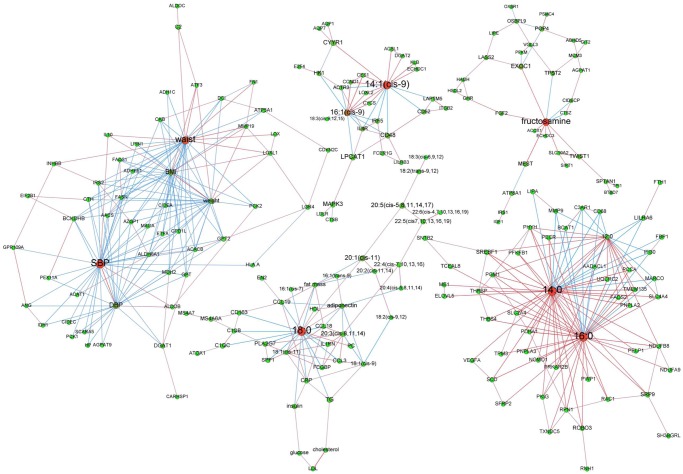
Adipose tissue networks during maintenance phase in women regaining weight.A sparse Graphical Gaussian Model (GGM) was used to estimate partial correlations in each set of variables and regularized canonical correlation analysis (CCA) was used to assess links between paired sets of variable. Clustering was performed using a spin glass model and simulated annealing. This analysis displays the variables that are connected independently from other variables. Graphs were laid out using force-based algorithms in Gephi 0.8.2 software. Nodes’ colors and font size indicate betweenness centrality. The red nodes have the highest betweenness and the green nodes the lowest one. Edge thickness is proportional to the strength of the correlation (CCA) or of the partial correlation (GGM). Edge color indicates the correlation sign: red for positive correlations and blue for negative ones. BMI, body mass index; CRP, C reactive protein; DBP, diastolic blood pressure; HDL, high density lipoprotein; LDL, low density lipoprotein; SBP, systolic blood pressure; TG, plasma triglycerides; waist, waist circumference.